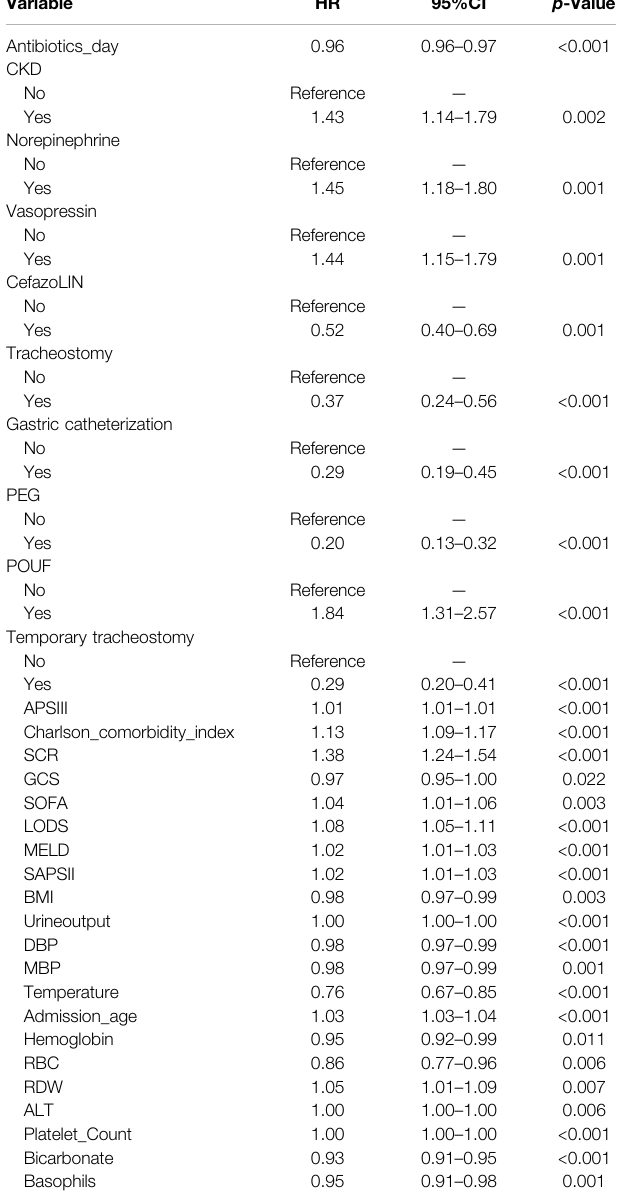
TABLE 2 | The results of univariate cox regression analysis.